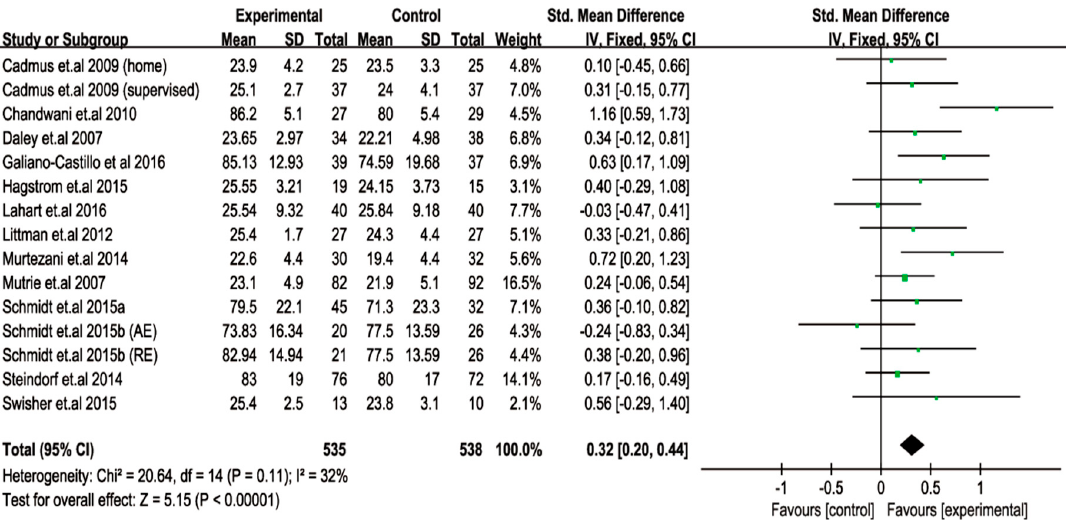
Figure 4. Pooled outcome of the changes in social function after exercise intervention in patients with breast cancer. SD, standard deviation; IV, inverse variation; CI, confidence internal; df, degrees of freedom.